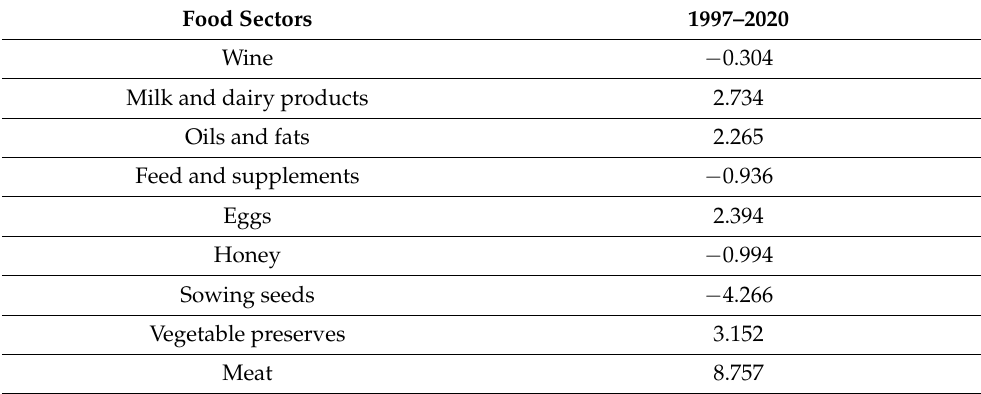
Table 6. Trend indices of the fraud rates in the food sectors for the period 1997–2020. Food